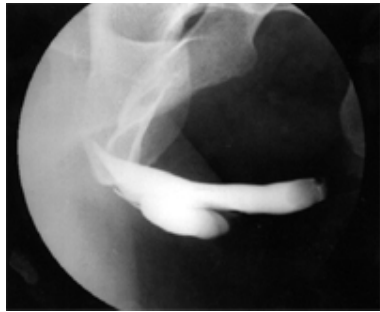
FIGURE 1 . Ascending urethrogram showing filling of Cowper's duct.